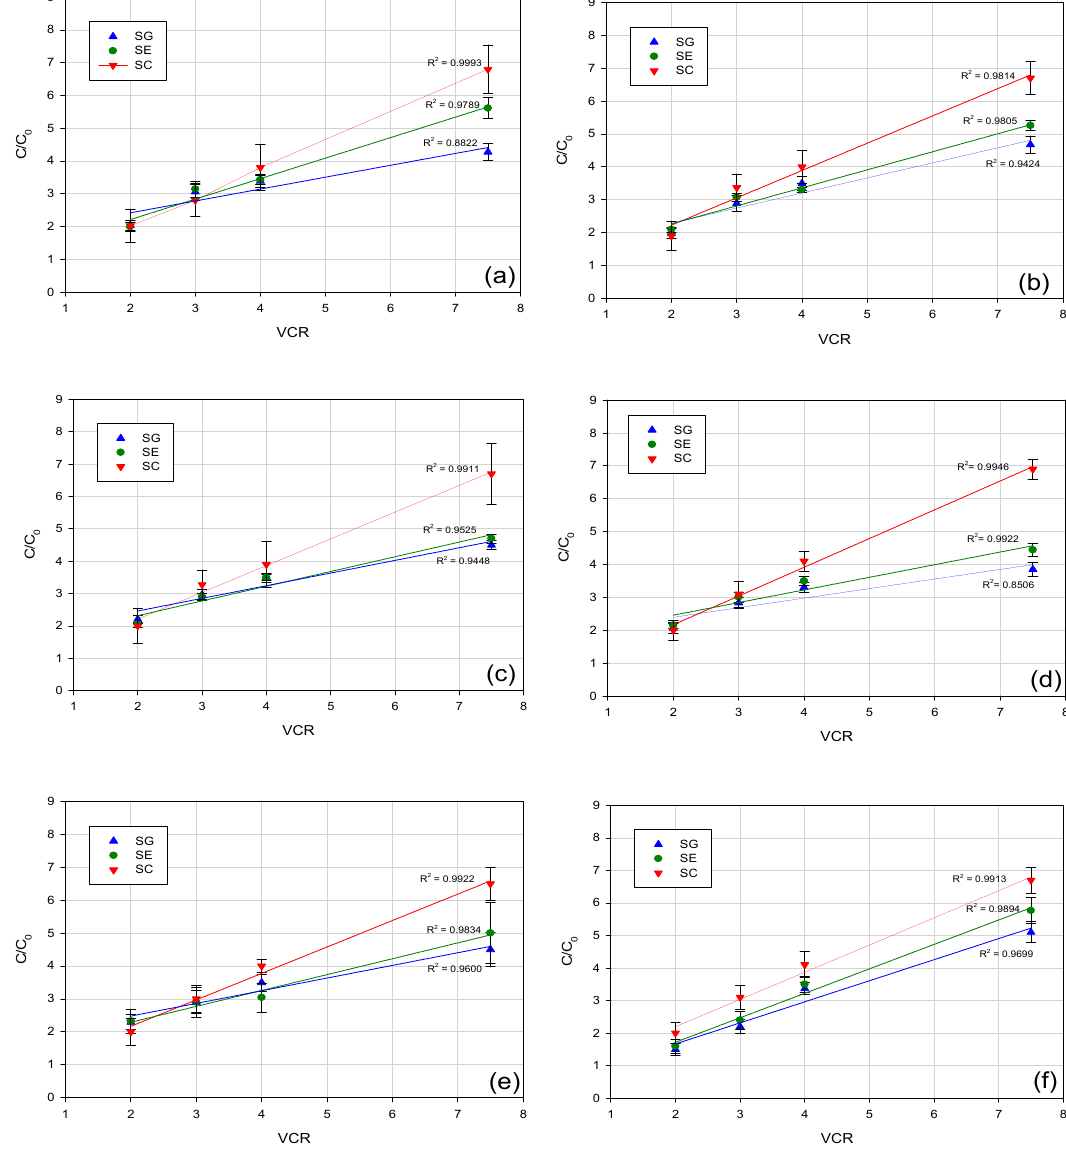
Figure 7. Profile of concentration factor with volume concentration ratio (VCR) for: ( a ) octanol; ( b ) linalool; ( c ) terpinen-4-ol; ( d ) α -terpineol; ( e ) cis-carveol; ( f ) karvon.